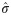
Spread values from Experiments 1 (2AFC_g), 2 (4AFC_g), & 3 (4AFC_l).Left panels show the spread value (σ) (i.e. inverse of the slope, with units of log10 arcsec) as a function of age. Right panels show the distribution of spreads for each experiment. A. Results from Experiment 1. B. Experiment 2; C. Experiment 3. Green dots are the individual spreads obtained from the fitting. The red dots in panels A and B correspond to the spread values of the participants described in Fig 3. Black lines are fitted regression lines (dashed lines: 95% regression confidence interval for the mean). A. σ^(age)2AFC_g = 0.632+0.308×log10(age). B. σ^(age)4AFC_g = 2.097–0.924×log10(age). C. σ^(age)4AFC_l = 2.295–0.996×log10(age). Top left of left panels shows the Pearson correlation between age and thresholds (log10(age) and σ).